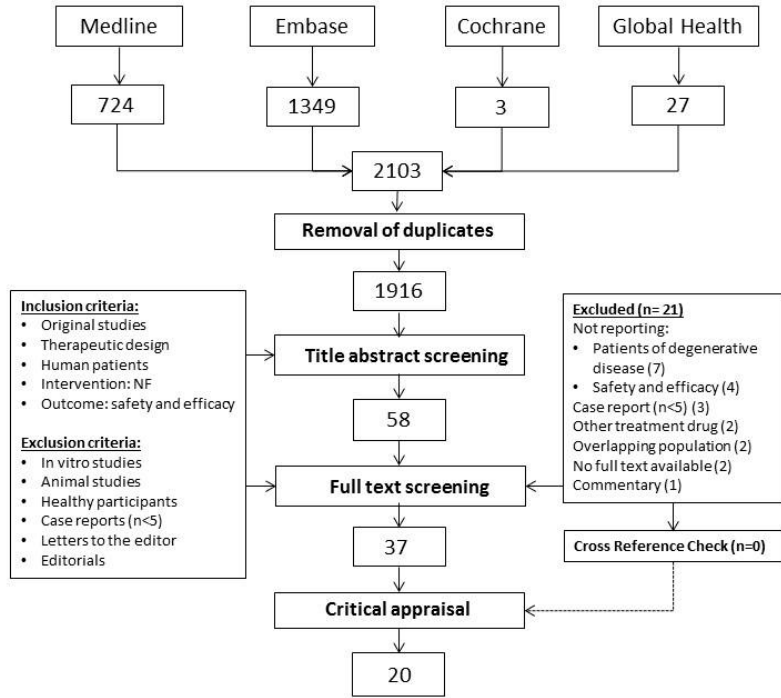
Figure 1. Flow chart demonstrating study selection process.